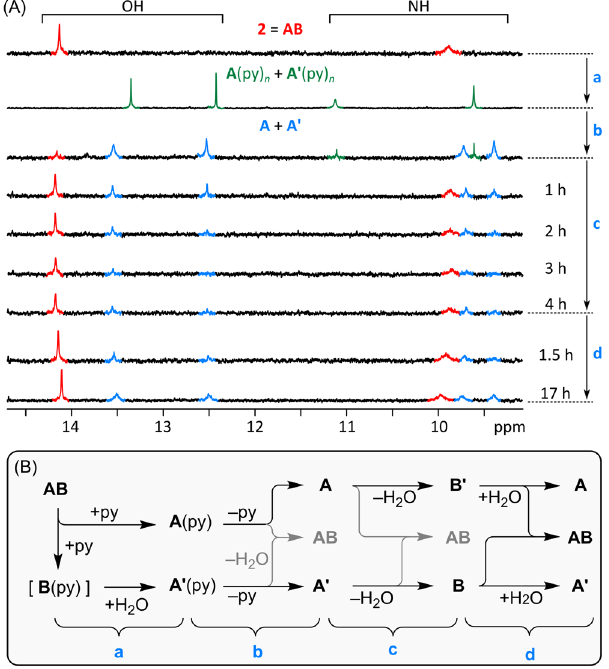
Fig. 8 Cleavage and reconstitution of 2 ( = AB). A changes observed using 1 H NMR spectroscopy (toluene- d 8 , room temperature). B Proposed